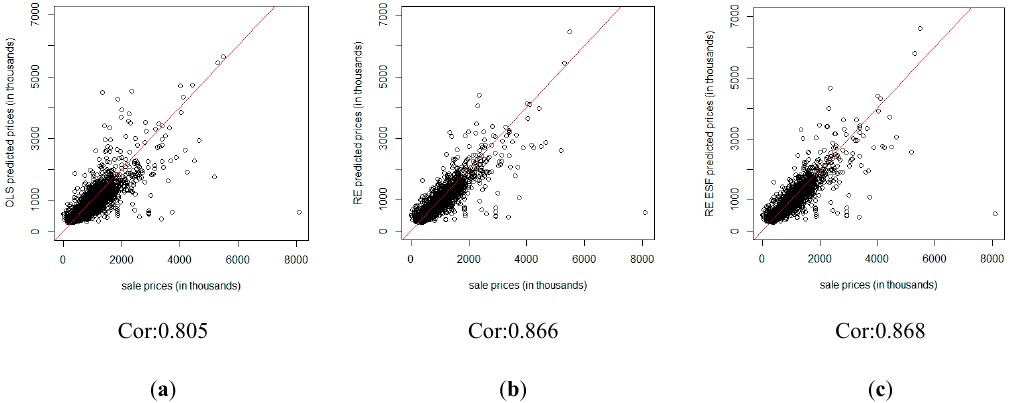
Figure 4. Scatterplots of observed house vs. predicted prices. ( a ) Observed house prices vs. predicted prices with the hedonic model. ( b ) Observed house prices vs. predicted prices with the multilevel model. ( c ) Observed house prices vs. predicted prices with the multilevel MESF model.